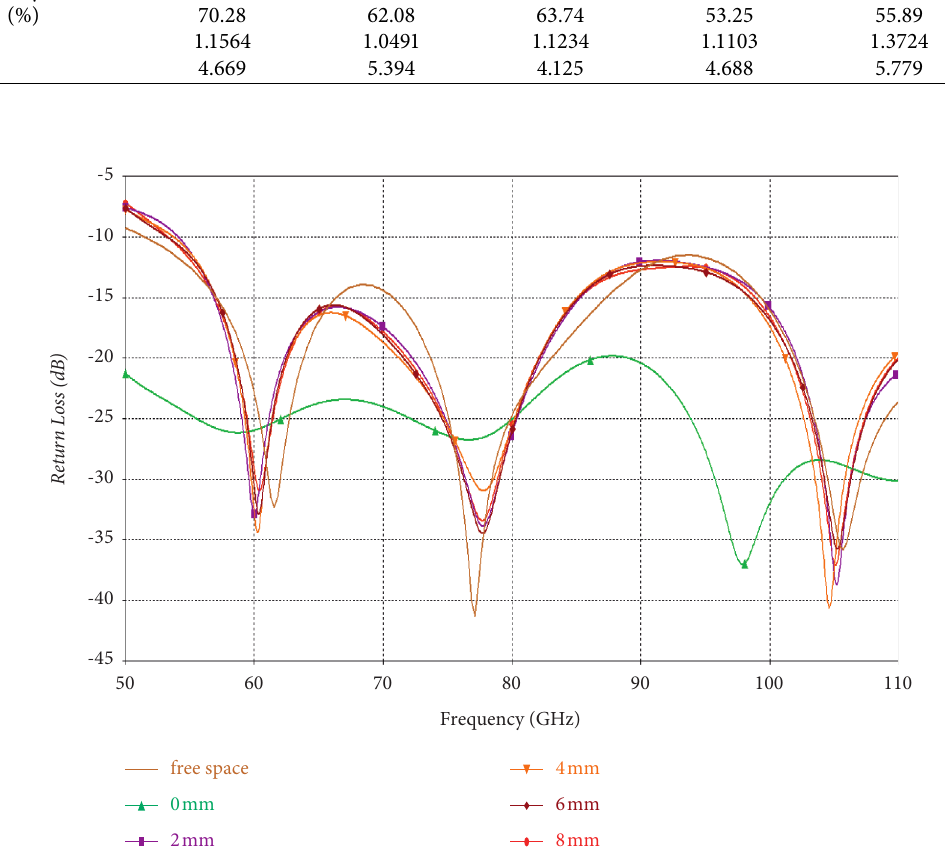
Figure 11: Return loss from the human body model and free space at various